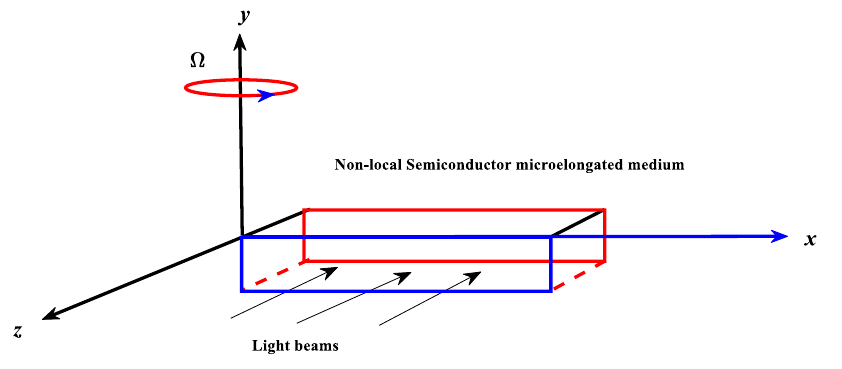
Figure 1. Geometry of the problem.